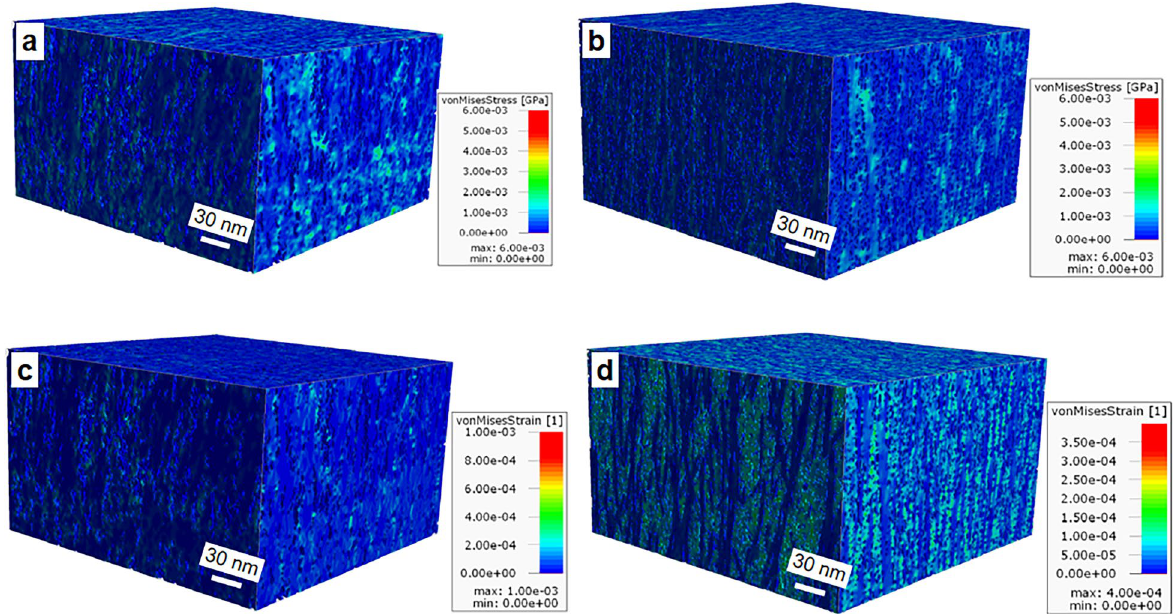
Figure 7. Bio-nano-mechanics of the native S2 wall (a,c) and idealized model (b,d). Spatial distribution of von Mises stress at nano scale in the 3D volume of the S2 layer ( a ) and idealized model ( b ) under six load cases (3 tensile and 3 shear) and the resulting strain on the native wall ( c ) and its simulated model ( d ) where the respective effective stiffness of the material was computed (see Fig. 8). Note the similarities at the nano level distribution of von Mises stress and strain between the two